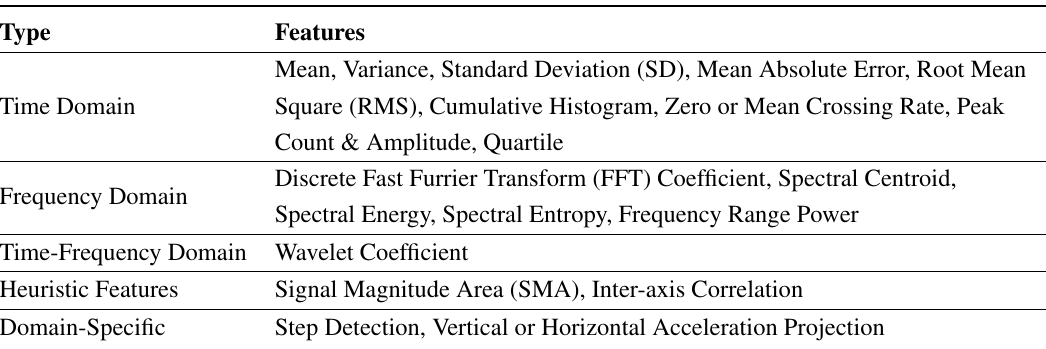
Figure 1. The steps involved in activity recognition using a feature-level sensor fusion. Table 1. The most widely used features [13]. Table 1. The most widely used features